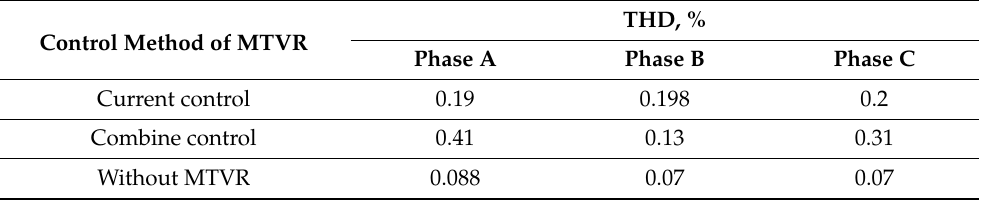
phases throughout the studied control interval for different methods of choke